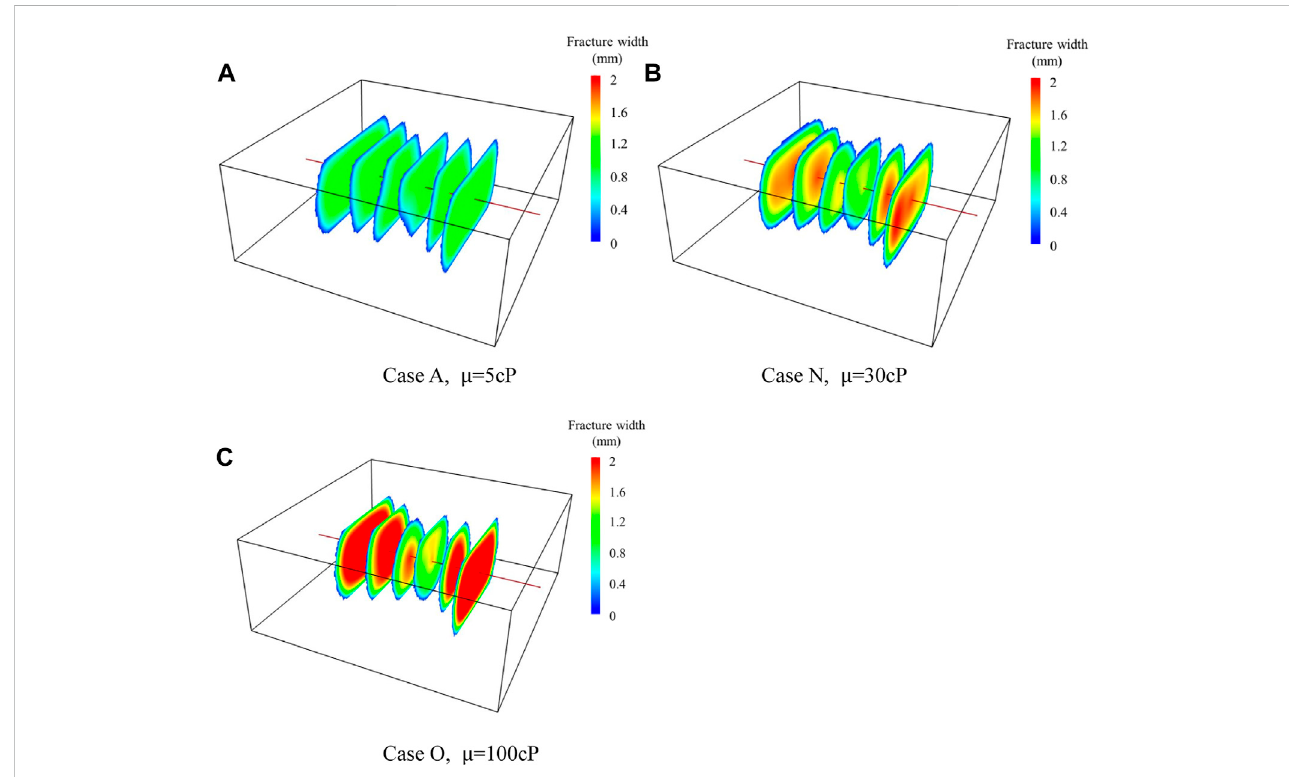
FIGURE 18 Fracture morphology for three cases with different fracturing fl uid viscosity. (A) Case A, μ = 5 cP. (B) Case N, μ = 30 cP. (C) Case O, μ = 100